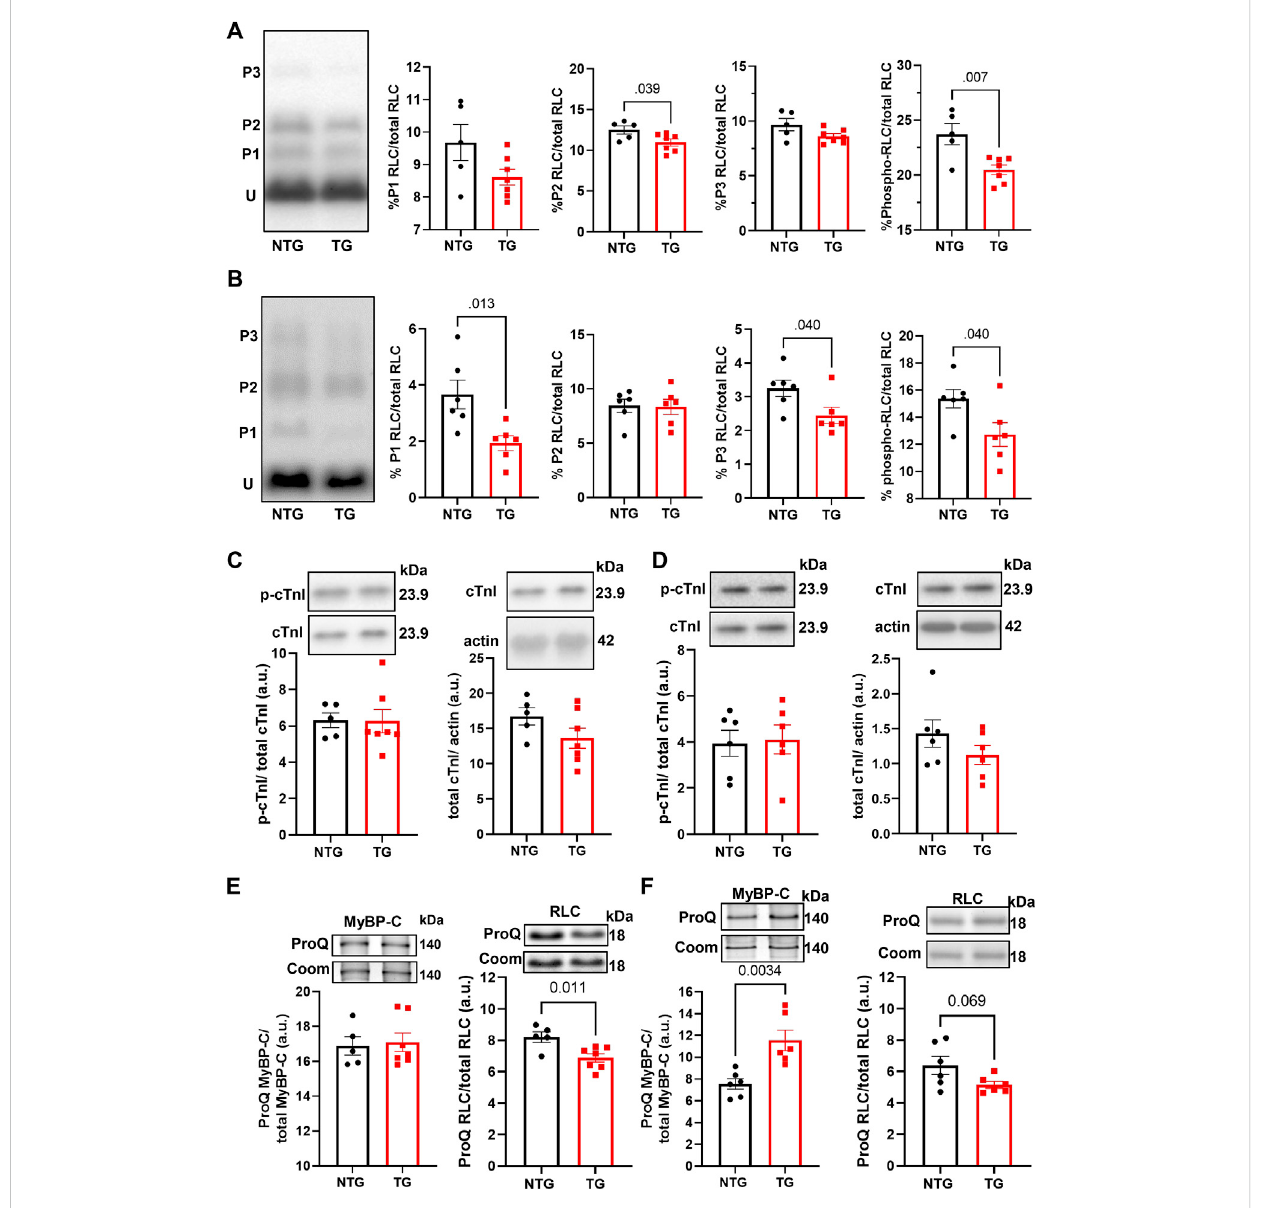
FIGURE 11 The Effects of R92Q-cTnT and age on myo fi lament phosphorylation. (A) PhosTag separation of RLC at P7. Left most panel representative PhosTag Western blot of RLC phosphorylated species (P1-P3) and unmodi fi ed RLC (U). The histograms depict the densitometric analysis of relative percent phosphorylation from the left most representative image. (B) PhosTag separation of RLC at P14. Left most panel representative PhosTag Western blot of RLC phosphorylated species (P1-P3) and unmodi fi ed RLC (U). The histograms depict the densitometric analysis of relative percent phosphorylation fromtheleftmostrepresentativeimage. (C) Western blotanalysis ofcardiactroponinI(cTnI)and itsphosphorylation abundanceatpositions23/24 atP7. TheleftmostpanelisananalysisofthephosphorylationabundanceswhiletherightmostpanelistheanalysisoftotaltroponinIabundance.Imagesabove the histograms are representative Western blot images. (D) Western blot analysis of cardiac troponin I (cTnI) and its phosphorylation abundance at positions 23/24 at P14. The left most panel is an analysis of the phosphorylation abundances while the right most panel is the analysis of total troponin I abundance.ImagesabovethehistogramsarerepresentativeWesternblotimages. (E) HeartsamplesfromP7micewereseparatedina15%SDS-PAGEgel stained with Pro-Q Diamond phospho-speci fi c stain and Coomassie G-250 total protein stain. The left most panel is the analysis of myosin binding protein-C (MyBP-C) phosphorylation abundance and the right most panel is the analysis of regulatory light chain. (F) Heart samples from P14 were separatedina15%SDS-PAGEgelstainedwithPro-QDiamondphospho-speci fi cstainandCoomassieG-250totalproteinstain.Theleftmostpanelisthe analysis of myosin binding protein-C (MyBP-C) phosphorylation abundance and the right most panel is the analysis of regulatory light chain. Data are presented as mean ± SEM and analyzed using unpaired Student ’ s t-test; N = 5 –